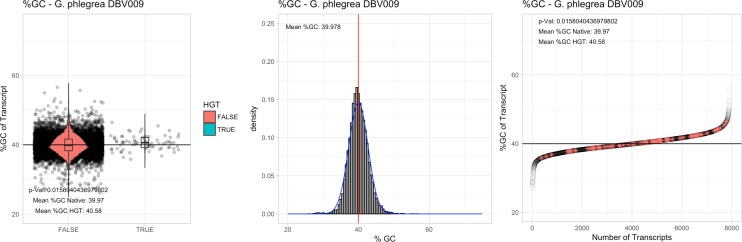
%GC – Galdieria phlegrea DBV009: (Left) Violin plot showing the %GC distribution across native transcripts and HGT candidates.(Mid) Cumulative %GC distribution of transcripts. Red line shows the average, blue line a normal distribution based on the average value. (Right) Ranking all transcripts based upon their %GC content. Red ‘*' demarks HGT candidates. As the %GC content was normally distributed, students test was applied for the determination of significant differences between the native gene and the HGT candidate subset.